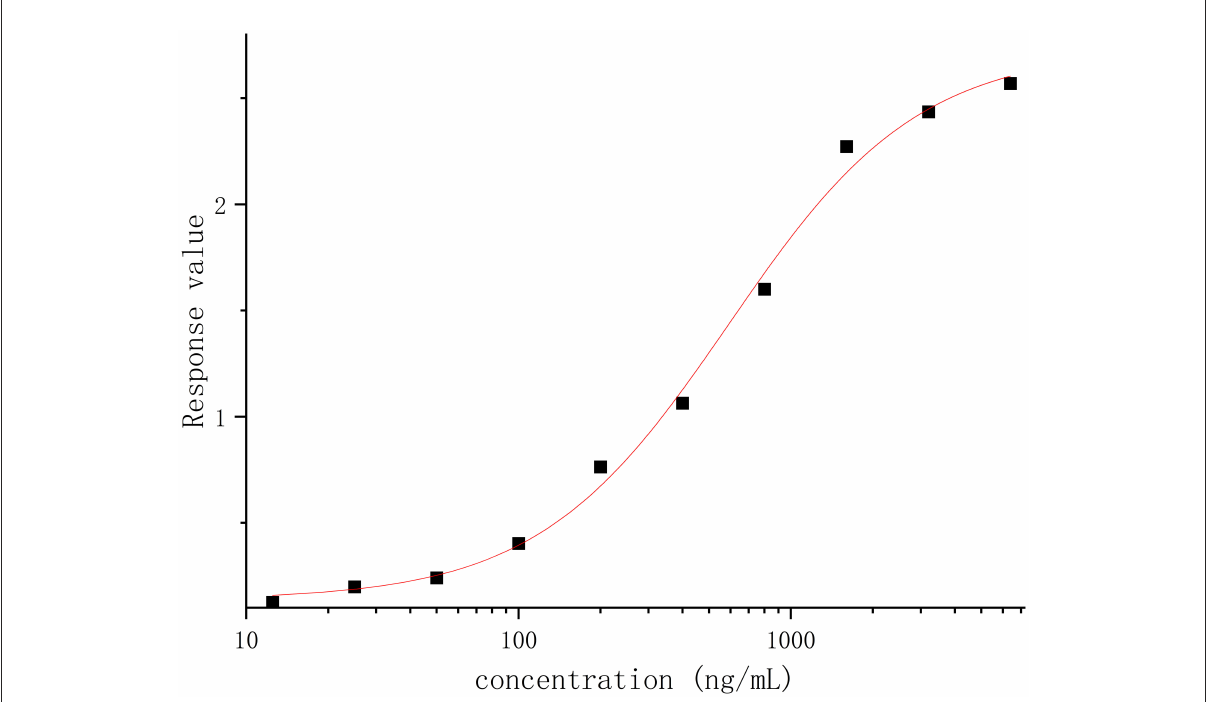
FIGURE2 The response (OD) vs. recombinant canine PD-1 fusion protein concentration was analyzed by the four-parameter fitting using the Origin 2021